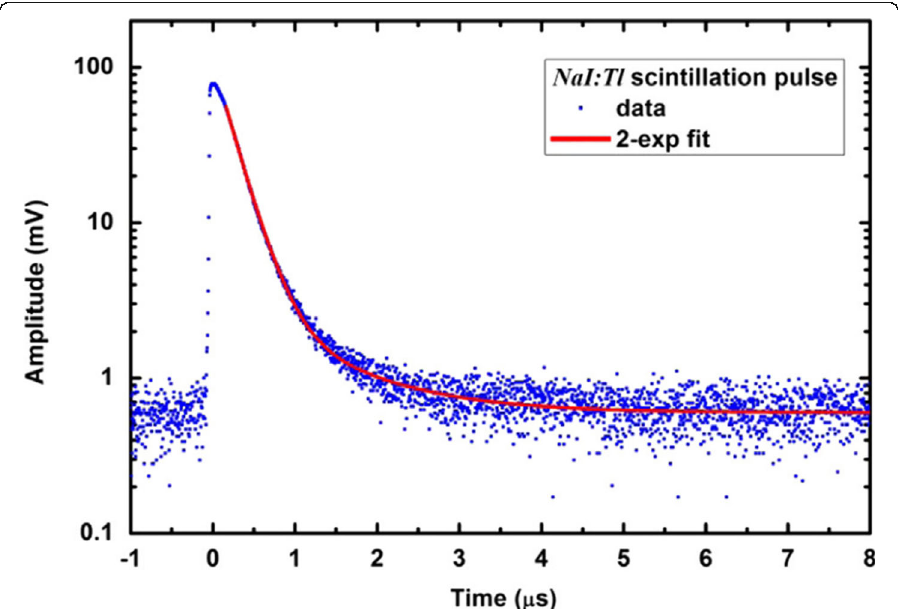
Fig. 3 Averaged scintillation pulse recorded for NaI:Tl irradiated with a 137 Cs source [48]. Two exponential terms fit to the data are presented with solid